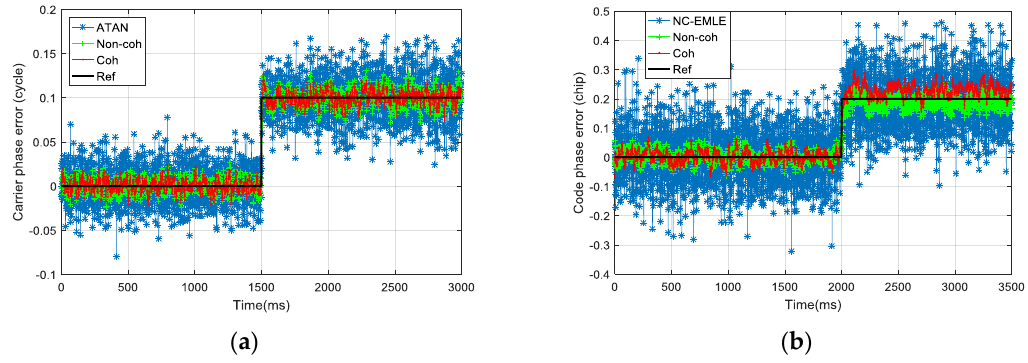
Figure 11. ( a ) The carrier phase error estimation in test scene A; ( b ) The code phase error estimation in test scene A. Table 2. Performance comparison of tracking error estimation methods in test scene A.